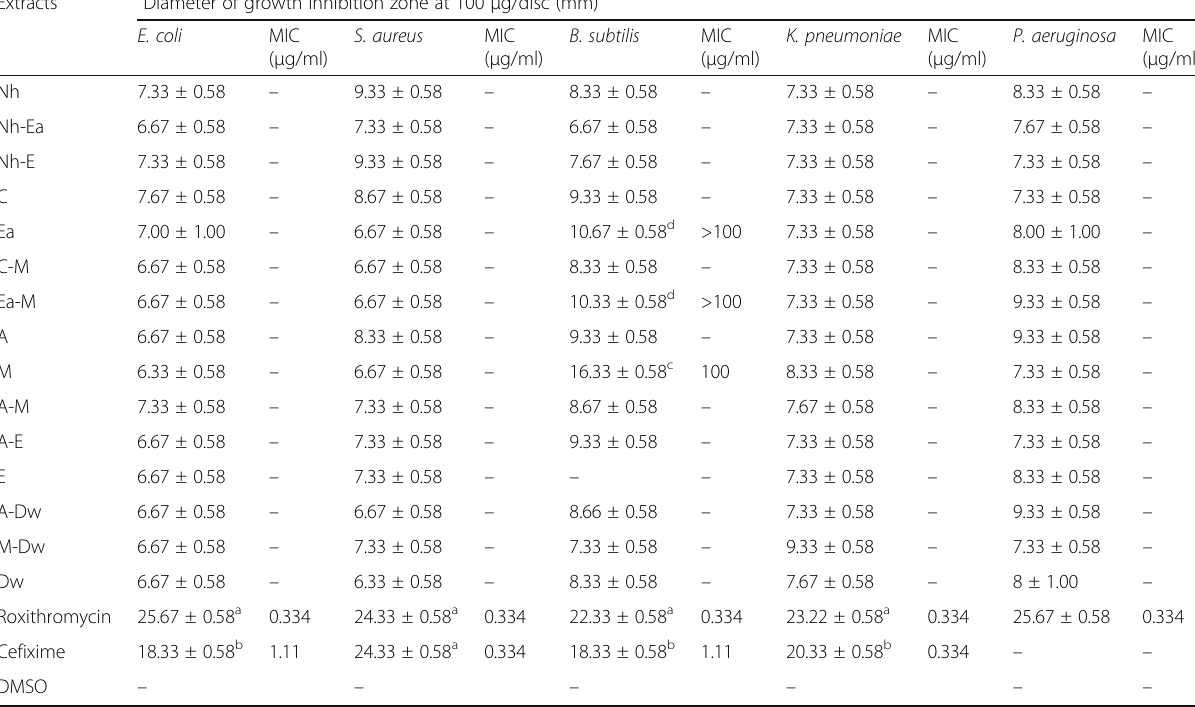
*Zone of inhibition including the diameter of disc (6 mm). Values are presented as mean ± Standard deviation ( n = 3). The values with different superscript ( a-d ) letters show significantly ( P < 0.05) different means. – : No activity in disc diffusion assay or not active (zone ≥ 10 mm) for MIC